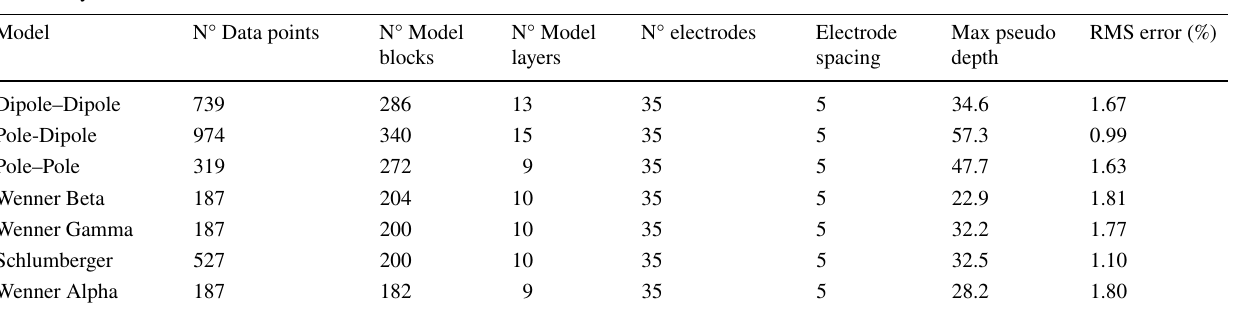
Table 1 Synthetic models characteristics